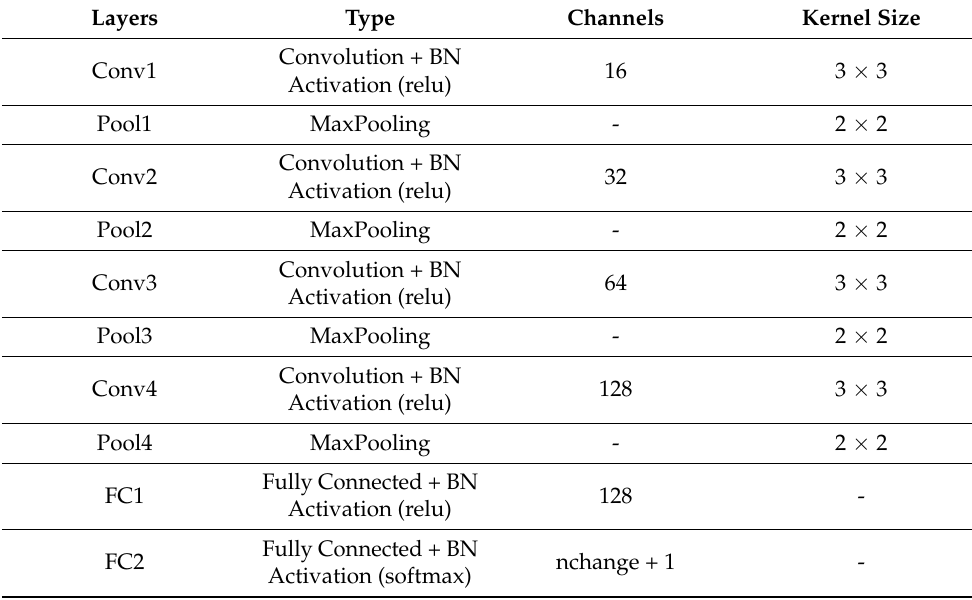
Table 1. Specific details of network